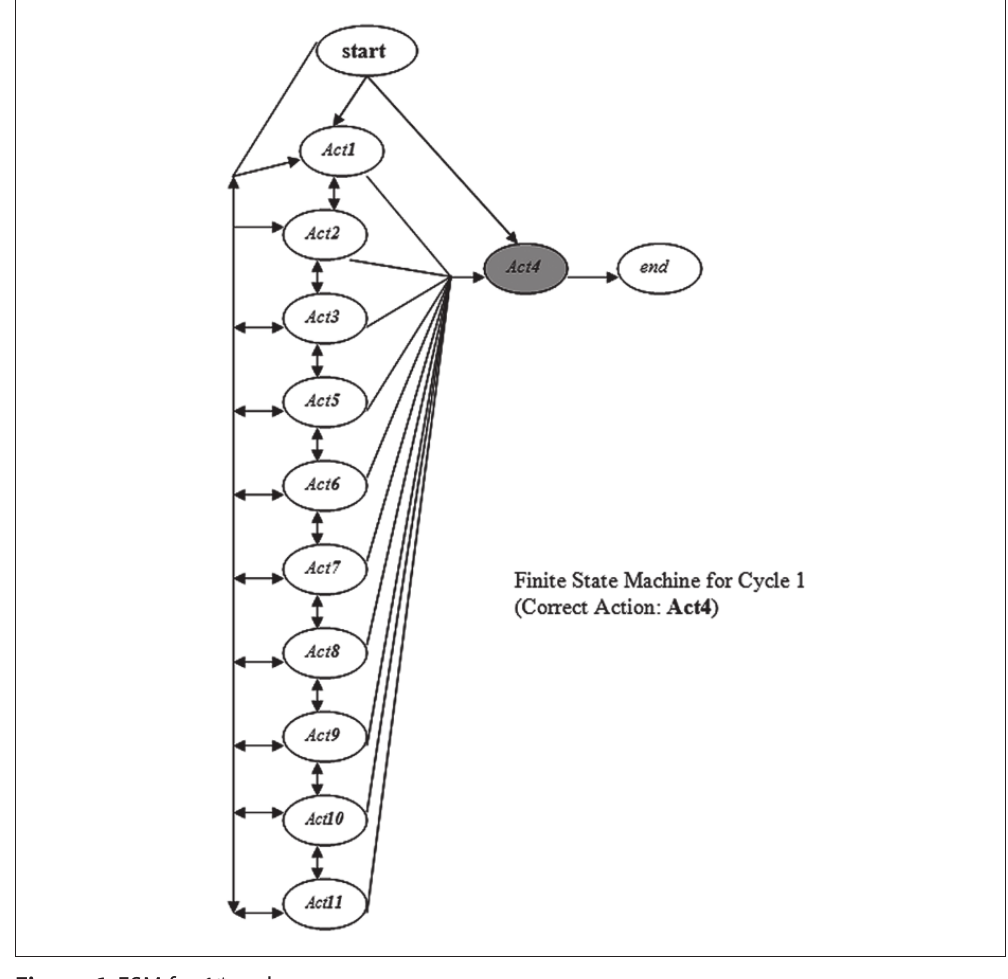
Figure 6 FSM for 1 st cycle